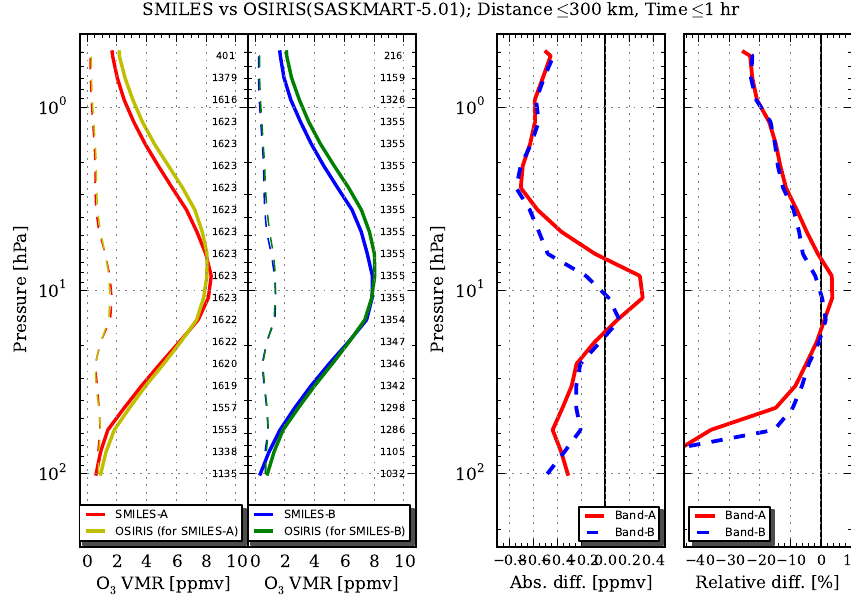
Fig. 19. Comparison between SMILES Band-A and OSIRIS. Same key as in Fig. 16. is produced at the Chalmers University of Technology, 0–7%. Relative differences increase with altitude and the largest values are found at the upper end of the vertical range 1075 (50–1hPa). Differences with Band-A of up to 10% are found close to the ozone peak altitude.